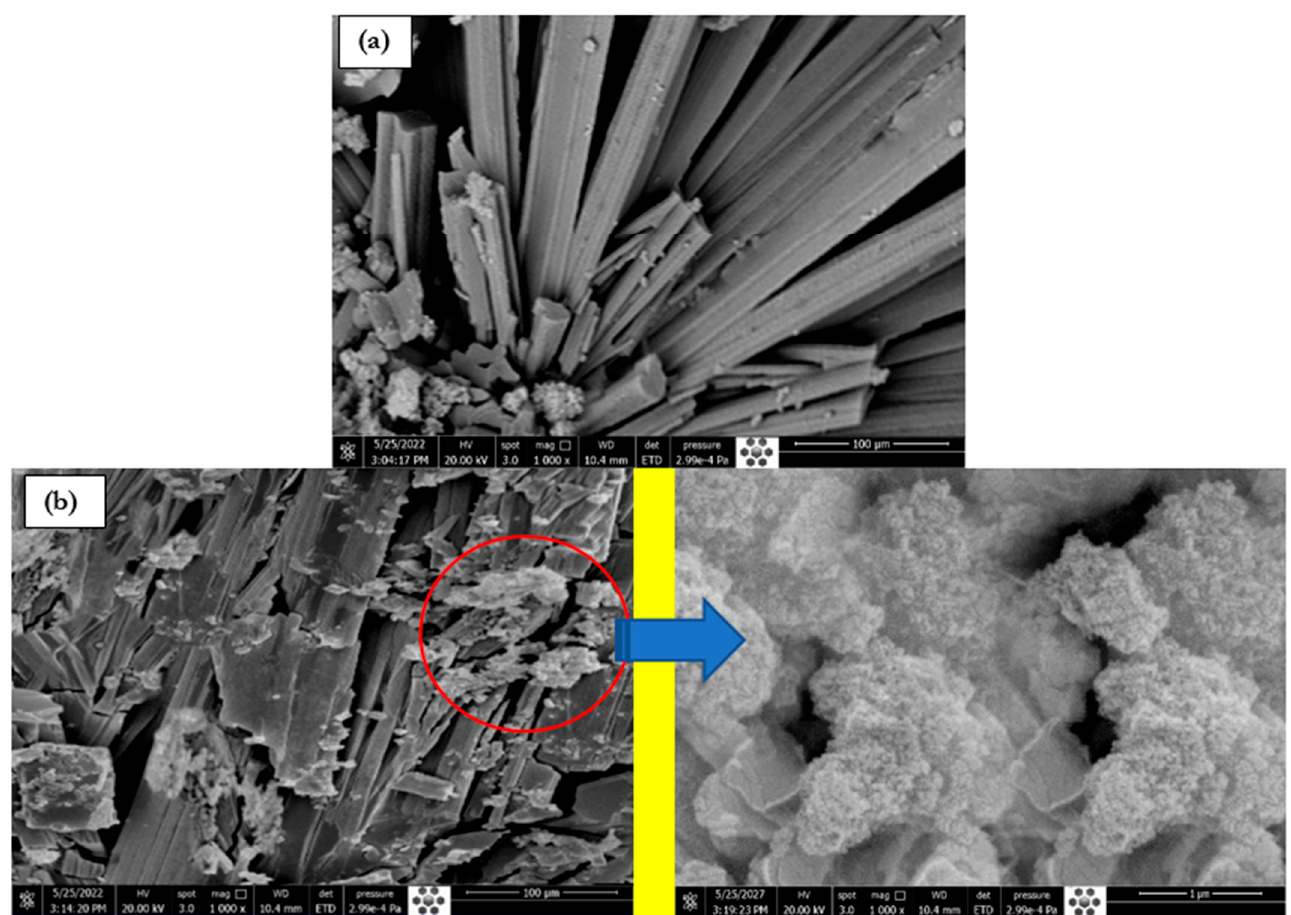
Figure 4. SEM images of ( a ) [PoPDA] TF and ( b ) [PoPDA/TiO 2 ]